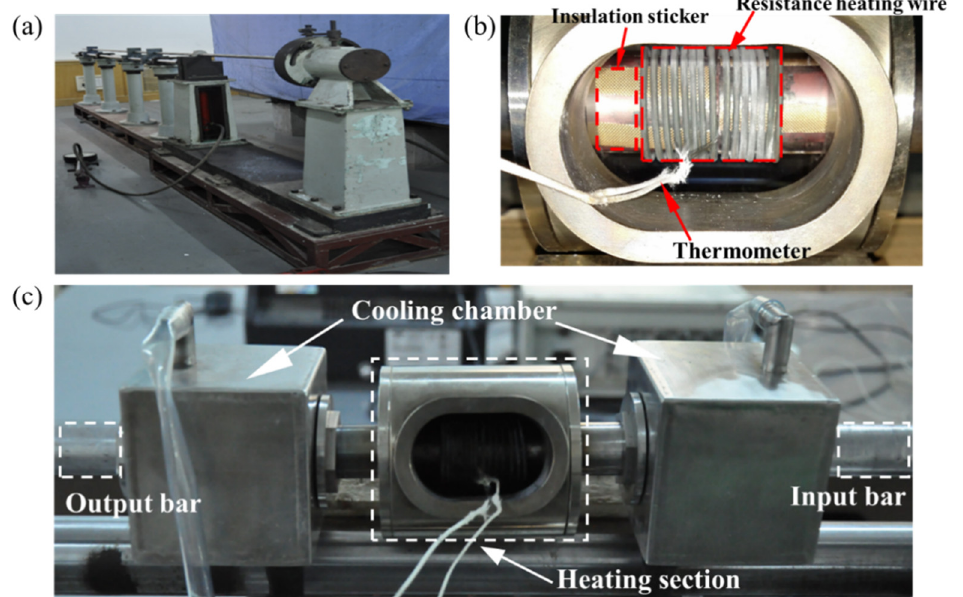
Figure 2. Modified Hopkinson torsion bar experimental device: ( a ) experimental device physical map; ( b ) specimen and high greenhouse assembly diagram; ( c ) high-temperature cooling system.